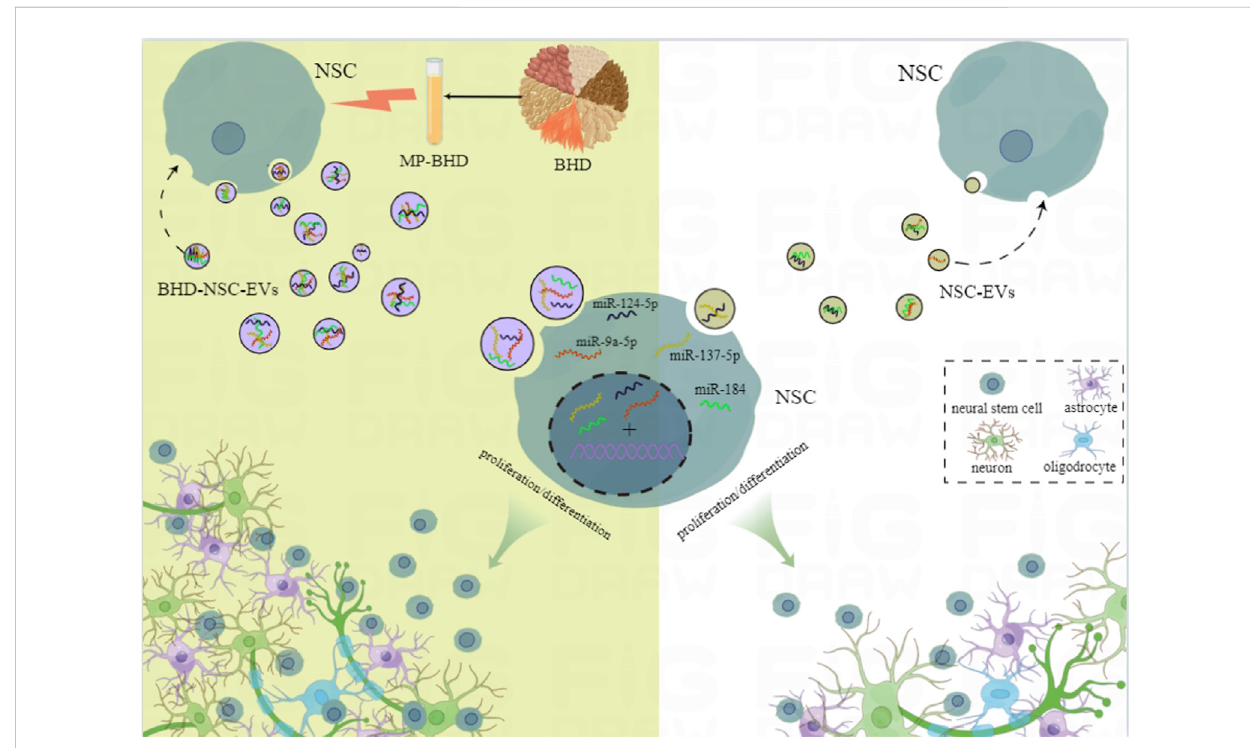
FIGURE 8 Schematic diagram of the potential mechanism of Buyang Huanwu Decoction for the neurogenesis in our study. The effective components of Buyang Huanwu Decoction contained in medicated plasma promoted the large-scale generation of extracellular vesicles derived from NSCs and recompiled the encapsulated miRNAs pro fi les. This kind of BHD-NSC-EVs signi fi cantly enhanced the proliferation and differentiation of NSCs and effectively accelerated neurological function recovery after ischemic stroke. MP-BHD, medicated plasma of Buyang Huanwu Decoction; NSCs, neuralstemcells;NSC-EVs,extracellularvesicles derivedfromneuralstemcells;BHD-NSC-EVs,extracellularvesiclesderivedfrommedicatedplasmaof Buyang Huanwu Decoction-preconditioned neural stem